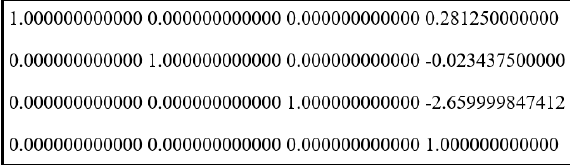
Figure 23. The 4x4 transformation matrix as a result from the match bounding-box centers registration method